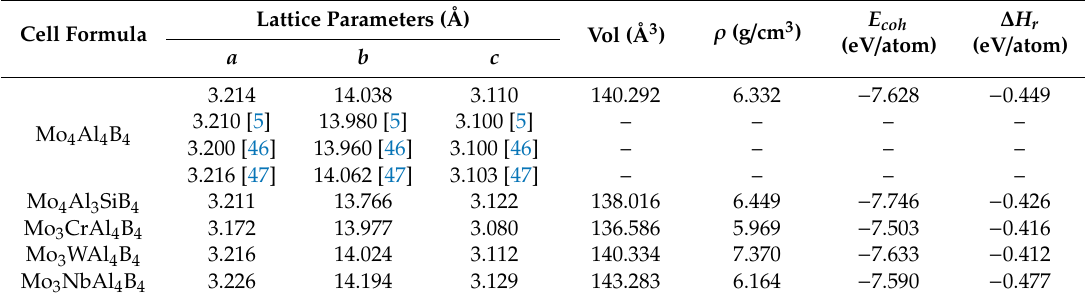
Table 1. The calculated lattice parameters, density, cohesive energy, and formation enthalpy. Lattice Parameters Cell Formula